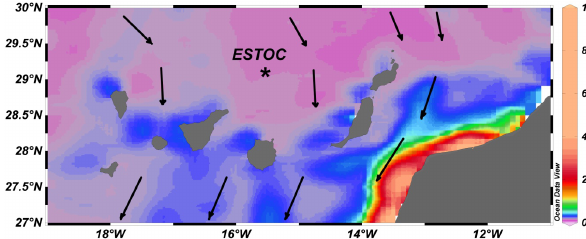
Fig. 1. Location of the ESTOC site (29 ◦ 10 0 N, 15 ◦ 30 0 W) and the Canary Islands in the Eastern North Atlantic on a satellite image (chlorophyll a in mgm − 3 ) from 19 March 2000 for the area and with indication of the The Canary current, the south- westward flow component of the North Atlantic subtropical gyre Fig. 1